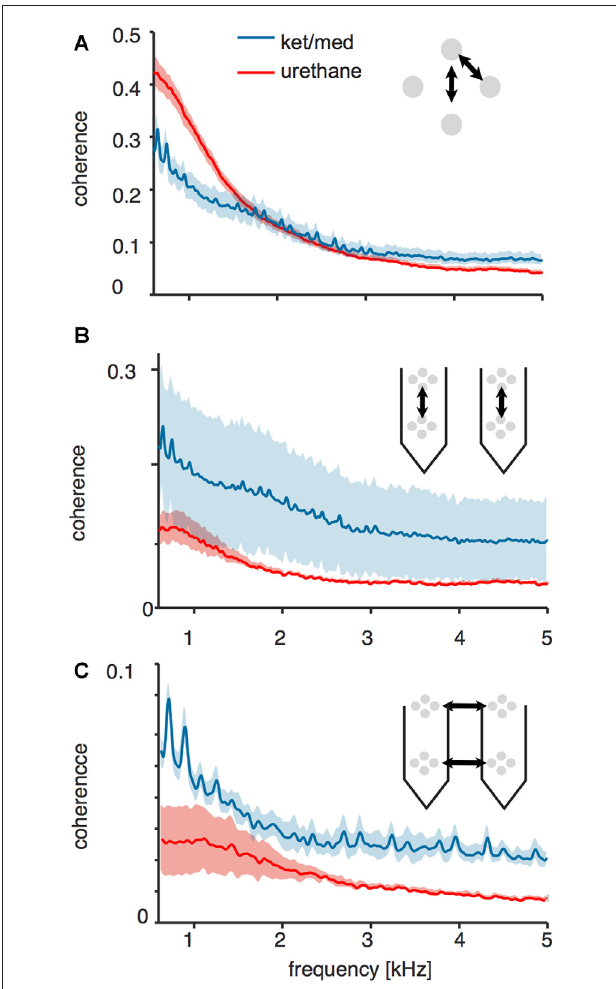
FIGURE 4 | Coherence of raw voltage traces across different sites of the probes. All panels show mean ± SEM coherence of voltages across different geometries of electrode site pairs for recordings obtained under ketamine/medetomidine (blue) or urethane (red) anesthesia. (A) Local electrode sites within the same tetrode. (B) Distant electrode sites across tetrodes along the same shank of the recording probe. (C) Distant electrode sites across tetrodes on different shanks.